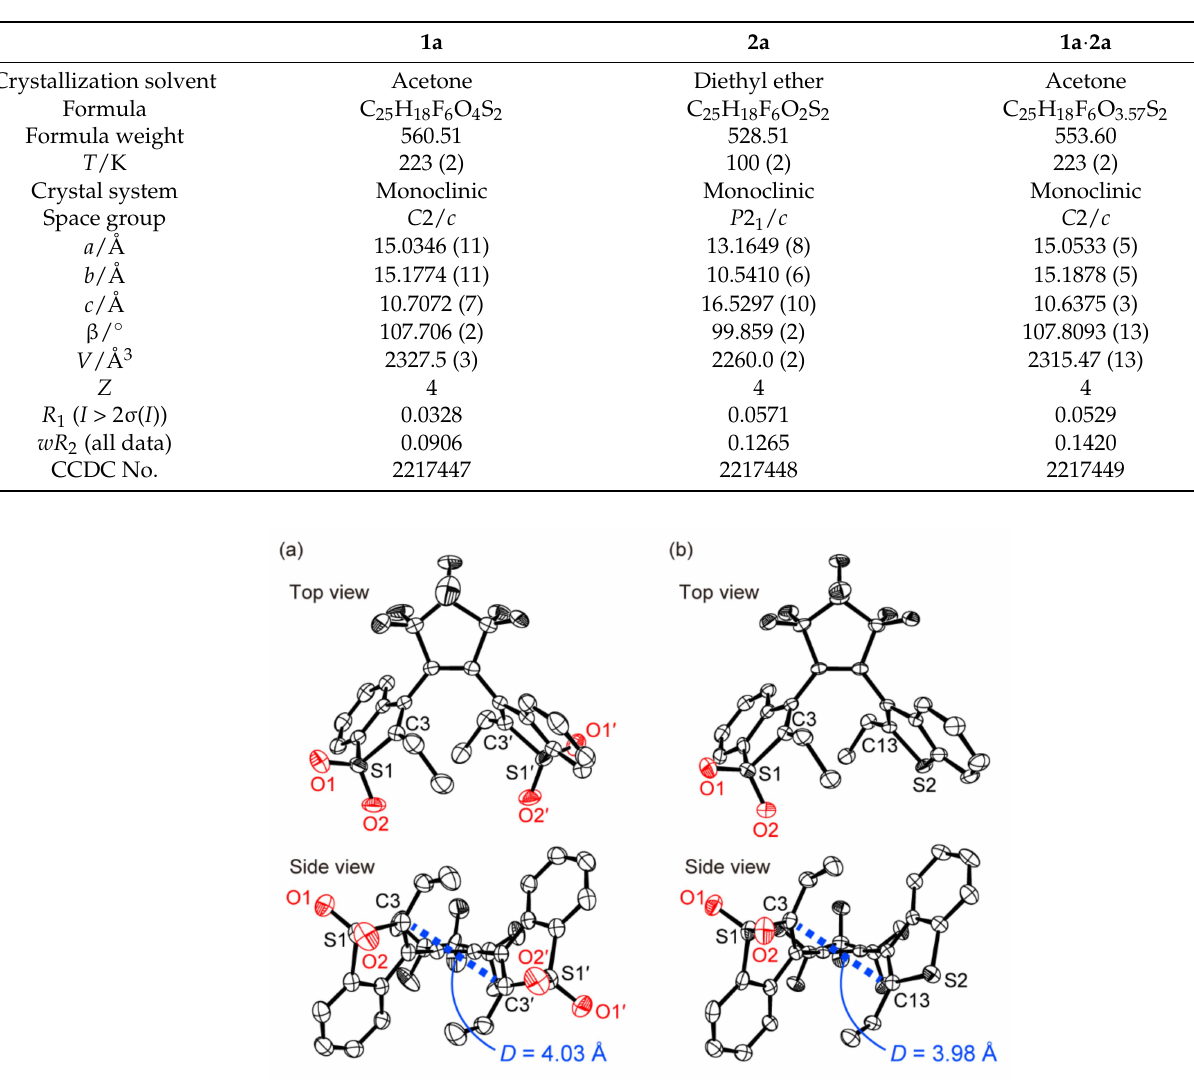
Figure 2. Molecular structures in single-component crystals of 1a ( a ) and 2a ( b ) determined by X-ray crystallographic analysis. The crystals of 1a and 2a were prepared by recrystallization from acetone and diethyl ether, respectively. The ellipsoids are shown at 50% probability level. The hydrogen atoms are omitted for clarity. D is the distance between the reacting carbon